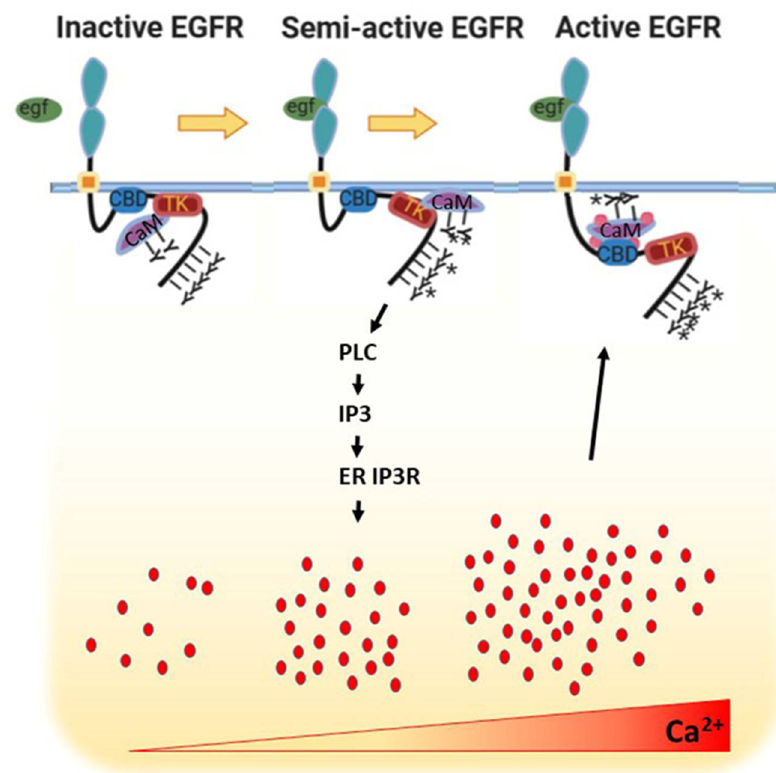
Figure 4. Model for sequential activation of EGFR by EGF, iCa 2 + , and CaM. Ligand binding results in partial activation of tyrosine kinase (TK) domain, phosphorylation of apo-CaM, and generation of IP3 by PLC gamma. Following release of Ca 2 + from the ER, CaM binds Ca 2 + and interacts tightly with the CaM-binding domain (CBD) of EGFR, dislodging it from its electrostatic interaction with the plasma membrane and permitting full activation of the TK domain. EGFR is depicted as a monomer for simplicity. Y *, phosphotyrosine. Red dots represent Ca 2 + . Adapted from Stateva et al. [110].